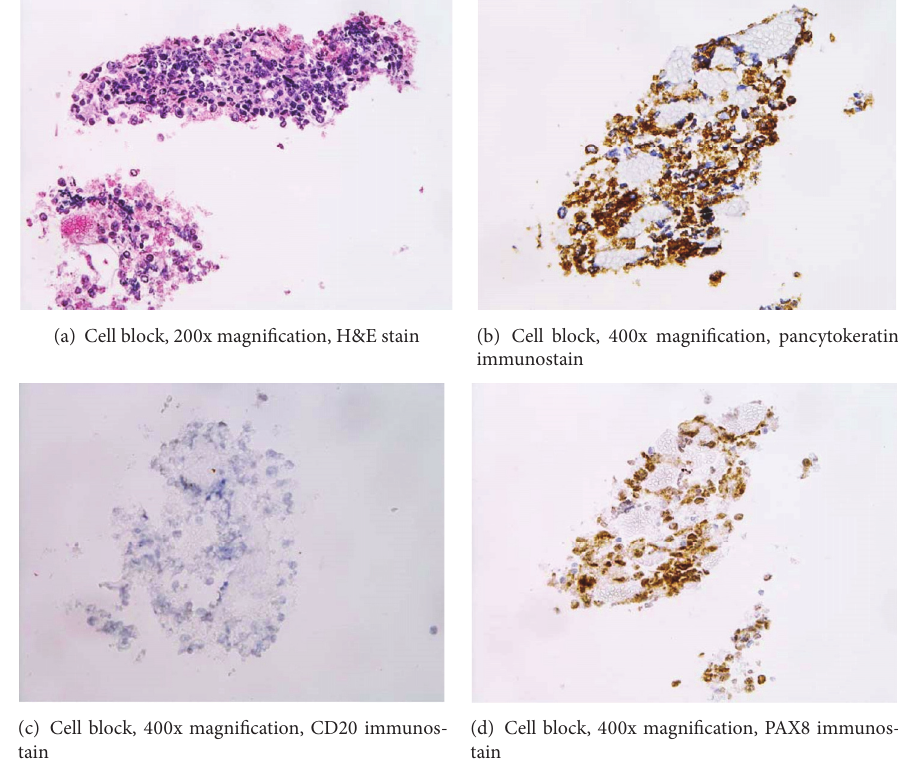
Figure 3: Cell block contained malignant cells expressing pancytokeratin cytoplasmic immunoreactivity and PAX8 nuclear staining but stained negatively with B lymphocyte marker